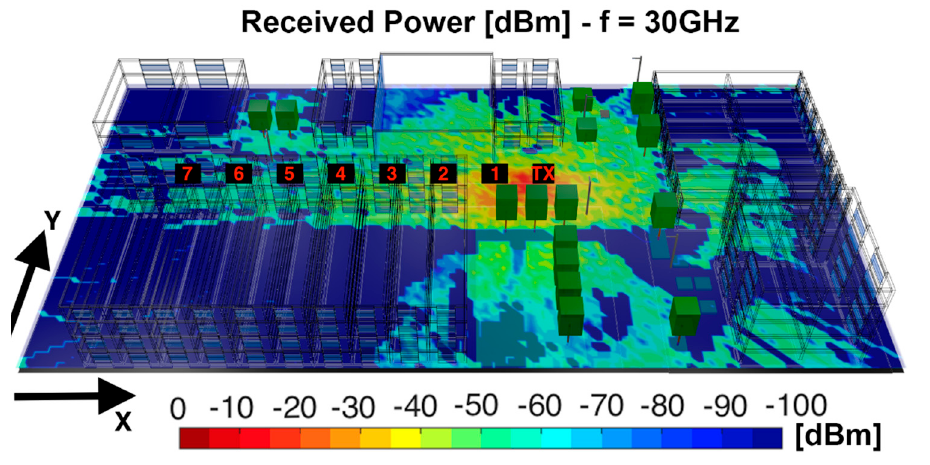
Figure 4. Bi-dimensional plane of received power [dBm] for a 1.3 m height with the position of the measurements points and transmitter position highlighted.